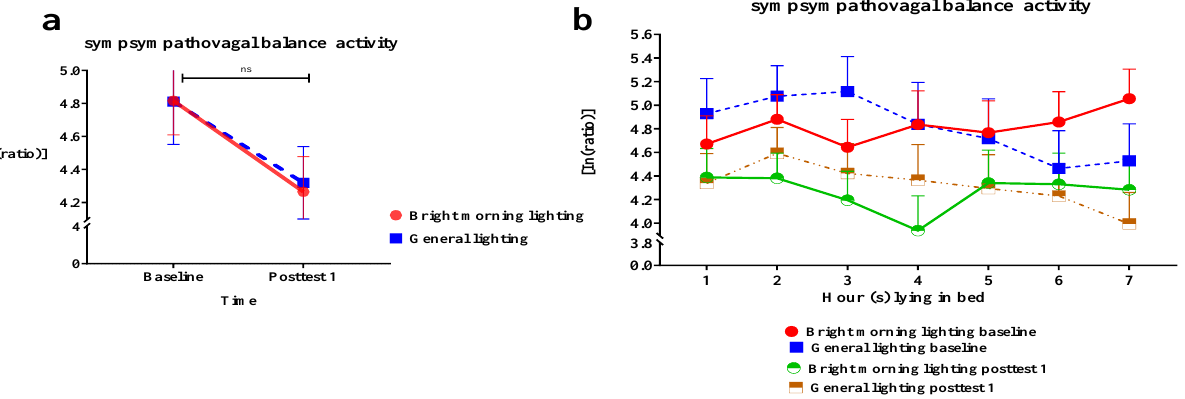
Figure 5. ( a ) A nonsignificant decrease in the low-frequency/high-frequency (LF/HF) ratio of the treatment group ( p > 0.05). ( b ) The treatment group demonstrated a significant decrease in the low- frequency/high-frequency (LF/HF) ratio while lying in bed for 3–4 h, resulting in a U-shaped curve.